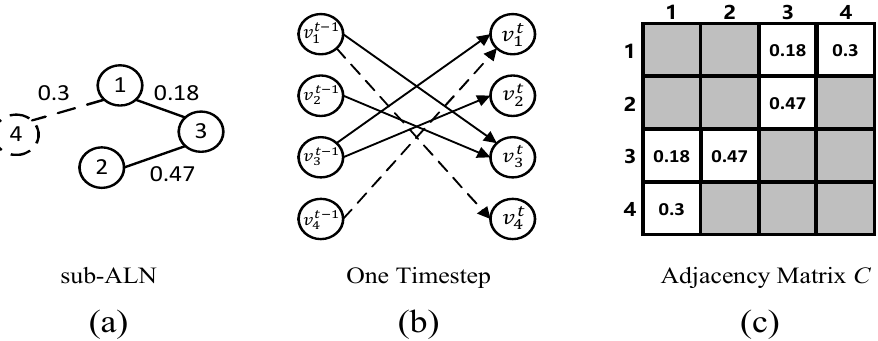
Figure 3. ( a ) Example sub-ALN. Solid lines are words in the event link, and dotted lines are first-order neighbors. ( b ) Unrolled one timestep. ( c ) Parameter binding of adjacency matrix. The parameter is the weight of corresponding edge in